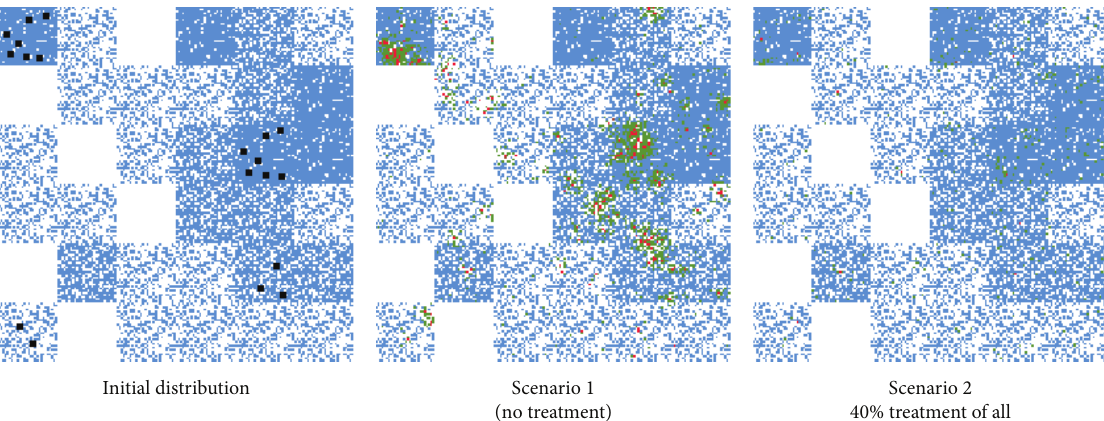
Figure 4: Spatial distribution of infected cases and deaths: initial (black), occupied (blue), latent (green), early stage (yellow), and late stage